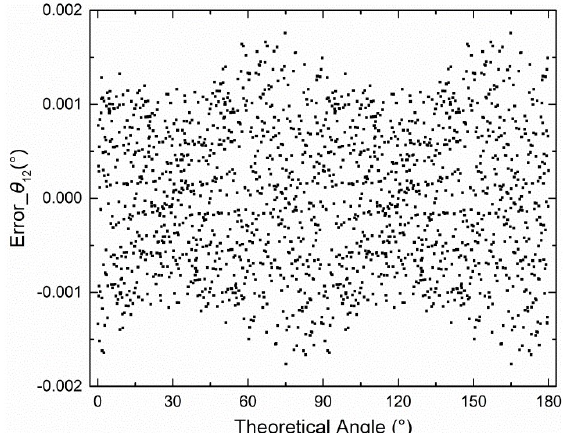
Figure 5. Errors for θ 12 when d = 0.5.